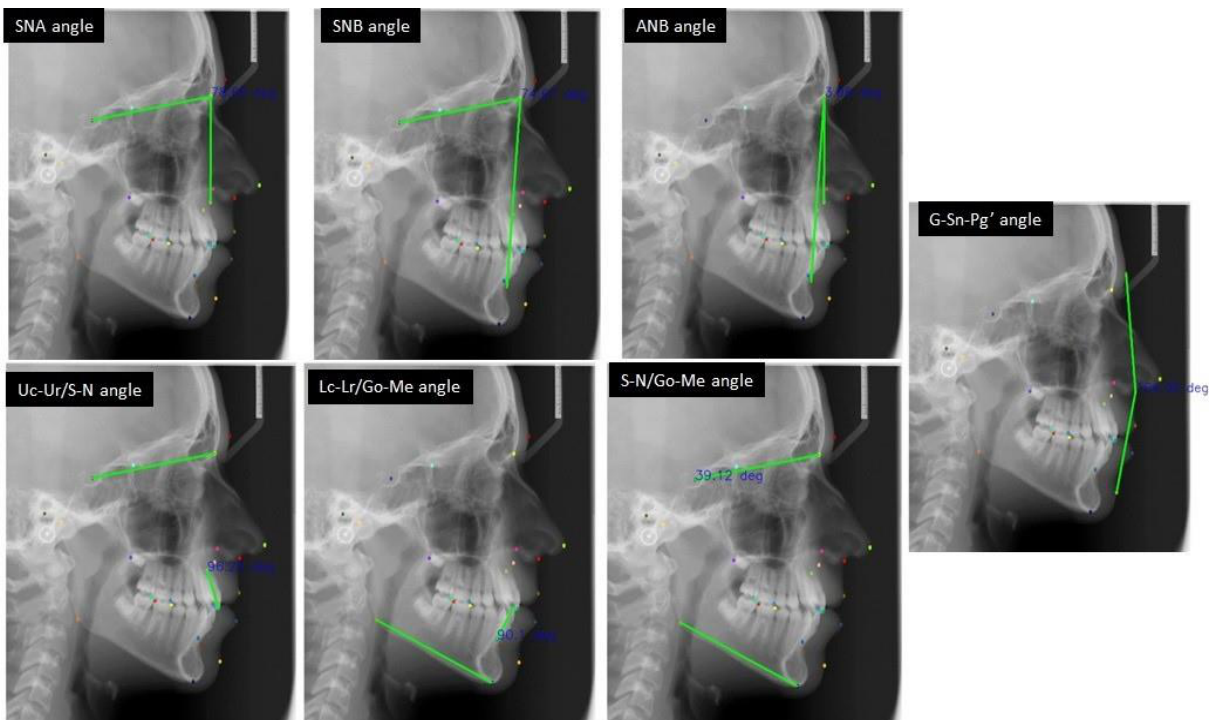
Figure 2. The seven angular measurements based on the cephalometric